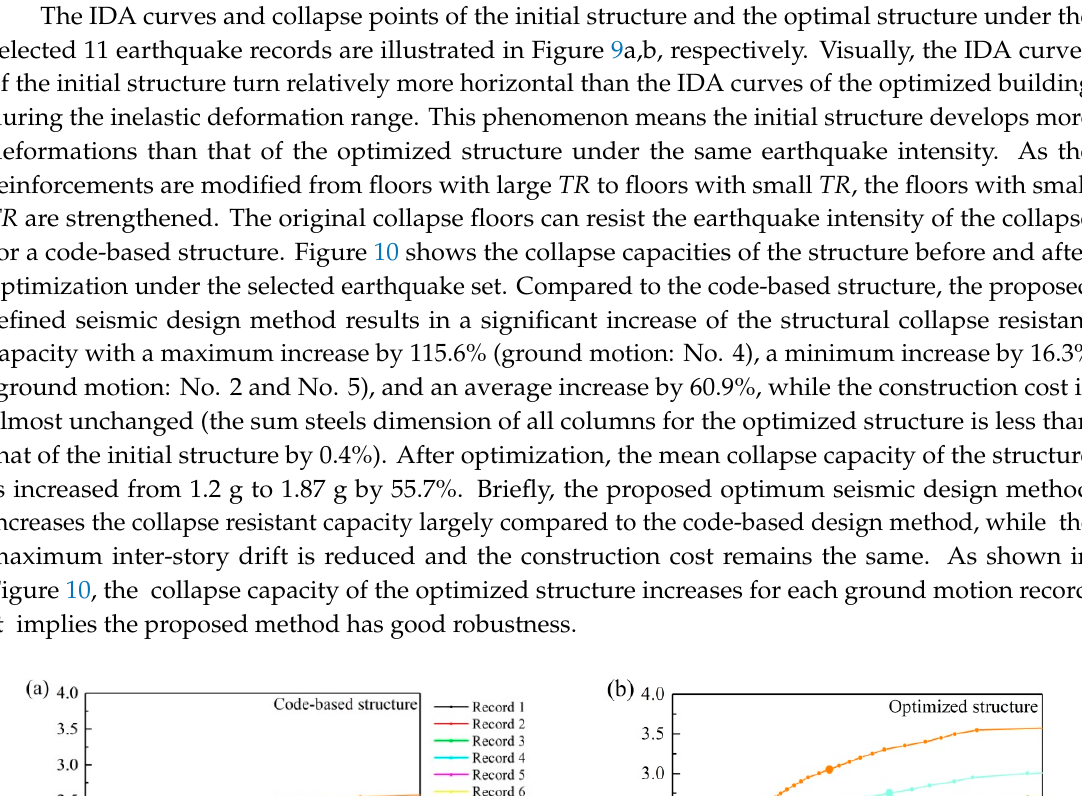
Figure 8. TR distribution comparisons of CSDBC-designed structure and optimized structure: ( a ) TR distribution of code-based structure at the earthquake intensity corresponding to collapse state of code-based structure, ( b ) TR distribution of optimized structure at the earthquake intensity corresponding to the collapse state of code-based structure.